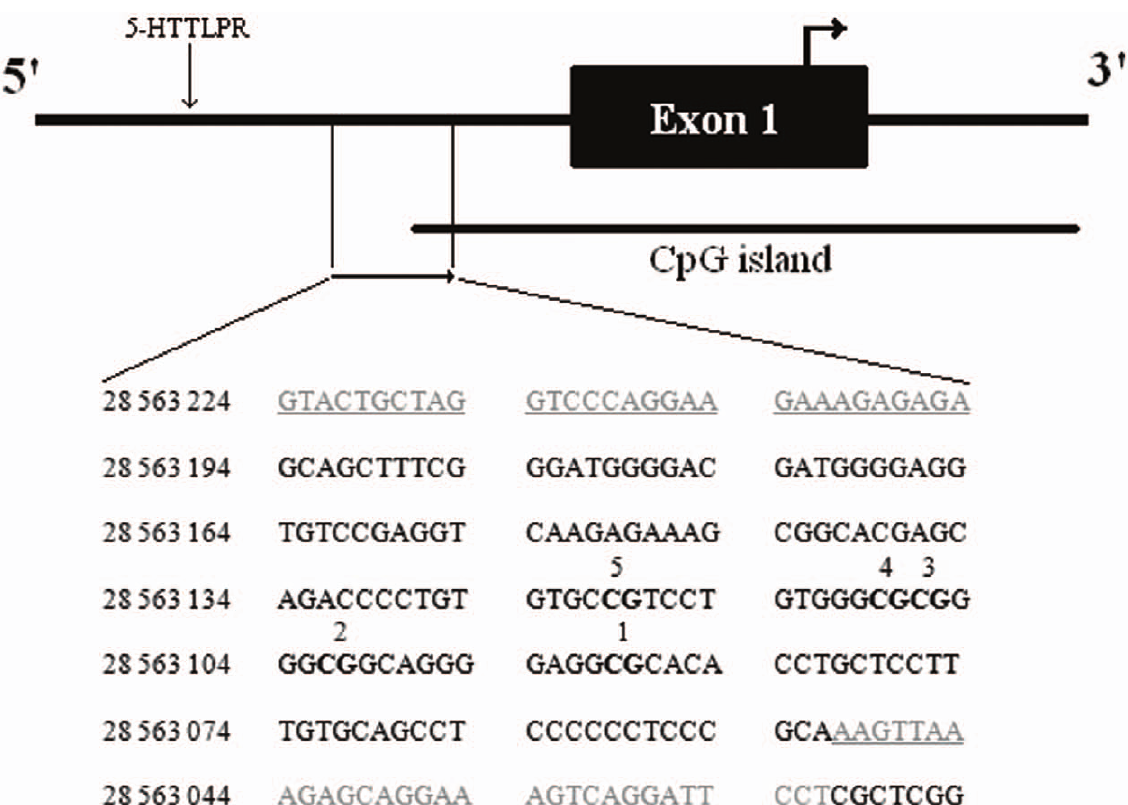
Figure 1. Representation of the SLC6A4 gene promoter region for bisulfite sequencing analysis. Analyzed CpG sites are bolded and numbered from 1 through 5. Coordinates are based on the GRCh37 build (NCBI Reference Sequence: NC_000017.10).